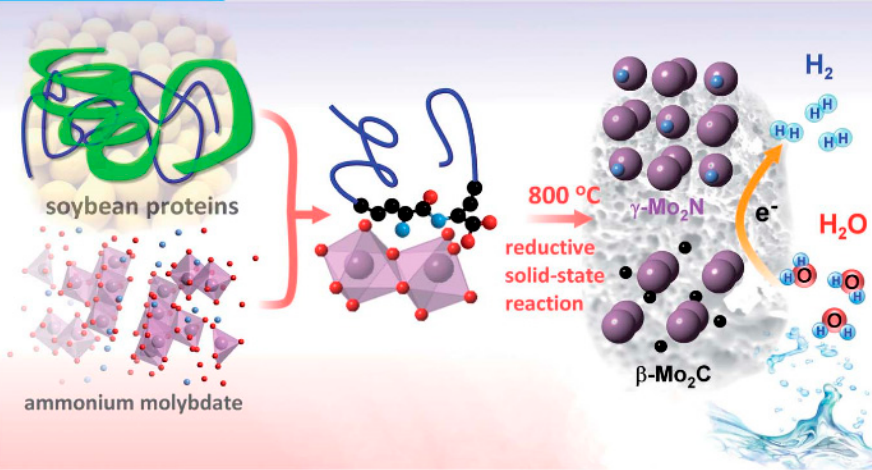
Figure 3. Design of a solid catalyst from soybeans and ammonium molybdate for electrochemical hydrogen production. A solid-state reaction between soybeans and the molybdate leads to their reductive carbonization and nitridation to form β -Mo 2 C and γ -Mo 2 N crystals. The structure of the amino moieties (blue balls) of soybean proteins is indicated. Plum balls: Mo, blue balls: N, black balls: C, and red balls: oxygen.